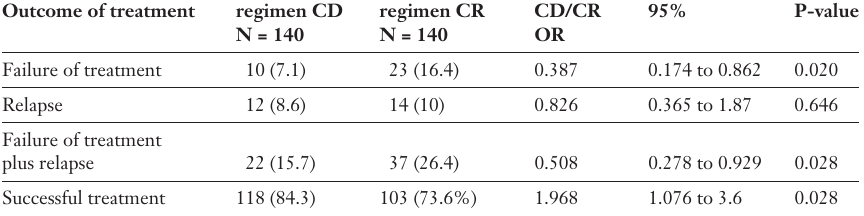
Results of treatment with co-trimoxazole plus doxycycline and co-trimoxazole plus